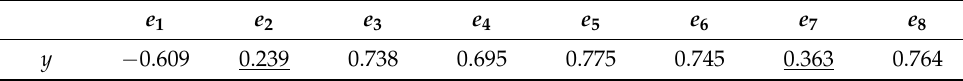
Table 3. Coefficient of association between visual saliency and eye movement indexes.